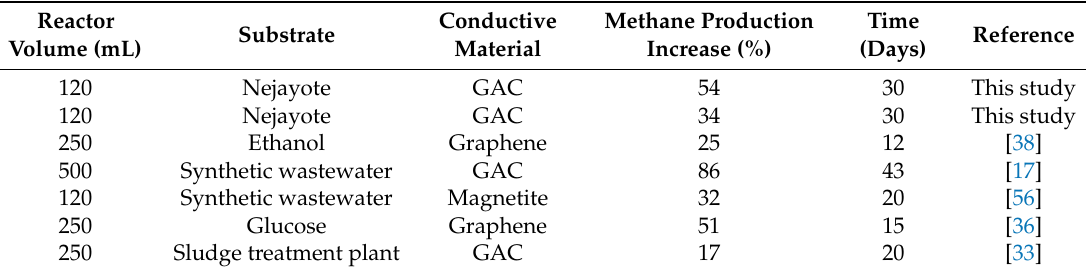
Table 3. Methane production increase with conductive